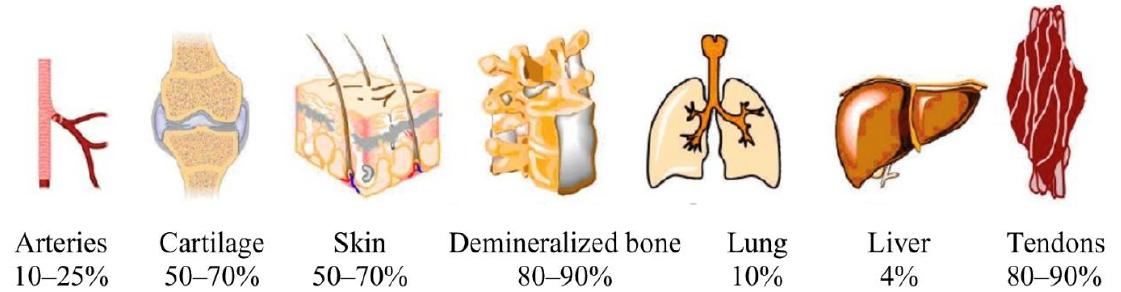
Figure 3. Collagen content of different body parts of animals. Reproduced with permission from Jafari et al., Polymers, 2020; 12(10):2230. ©2020 MDPI [24].